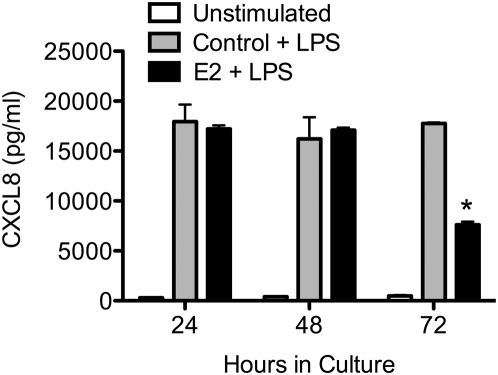
ERα expression mirrors E2 modulation of LPS-induced CXCL8 production.Monocytes were cultured for 24, 48 or 72 hrs. 10−7 M E2 or ethanol control was added during the final 24 hrs of culture. Subsequently, cells were stimulated in the presence or absence of LPS (10 ng/ml), for an additional 12 hrs. Culture supernatants were analyzed for CXCL8 by ELISA and reported as pg/ml. *, p<0.05 vs. control + LPS.